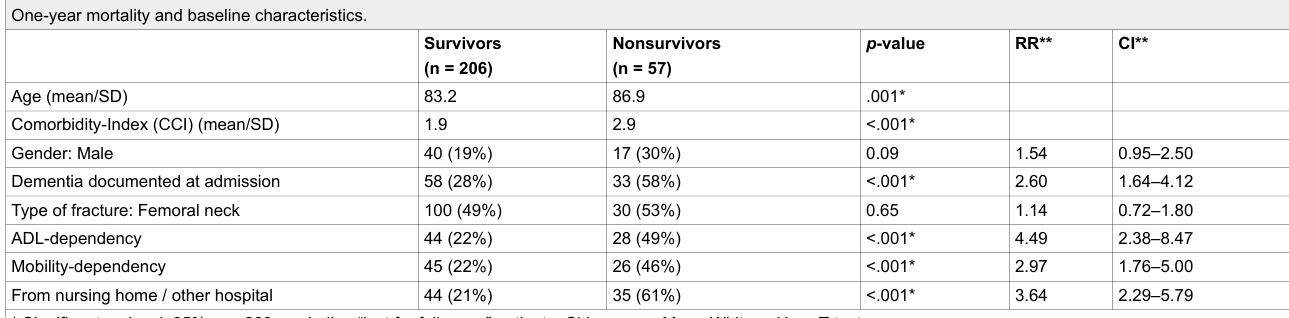
Table 2 One-year mortality and baseline